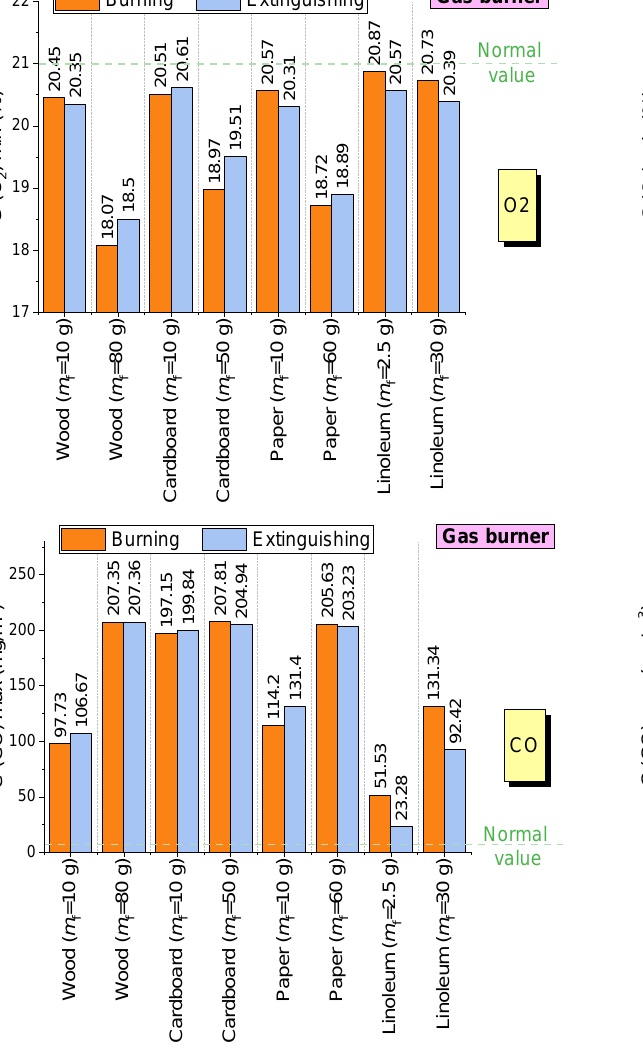
Figure 14. Trends of O 2 , CO, CO 2 , H 2 and CH 4 concentrations: 1 – hot plate heating without aerosol spray; 2 – spraying aerosol on the heated surface; 3 – spraying aerosol with no heating. Figure 15 presents cumulative histograms of threshold concentrations of gas components (O 2 , CO, CO 2 , H 2 and CH 4 ) recorded for all the model fires under study when reproducing the conditions of careless handling of fire (gas burner) and improper use of heating equipment (hot plate). The “normal value” in Figure 15 means the value corresponding to the sensor readings, when there is no pyrolysis of the combustible material. Burning